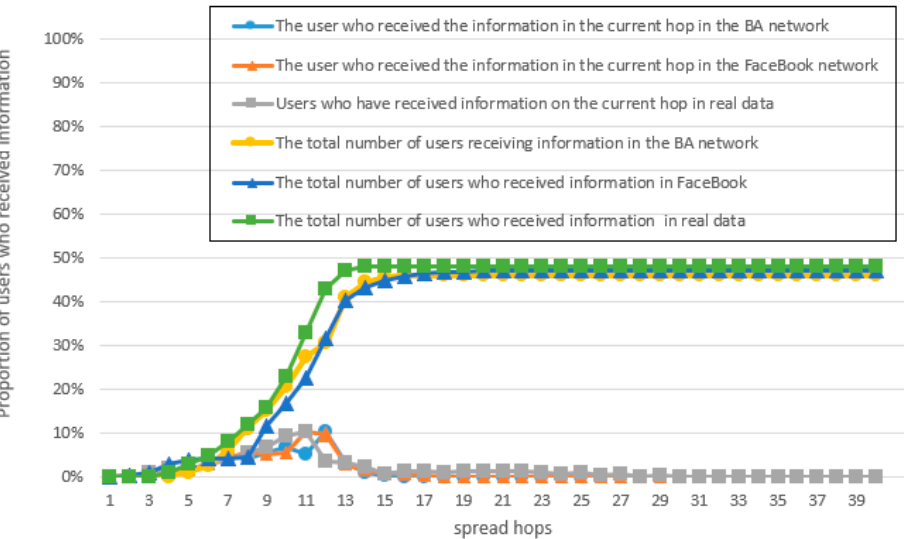
Figure 15. Dissemination of the privacy information of a low popular user between simulated data and real data.